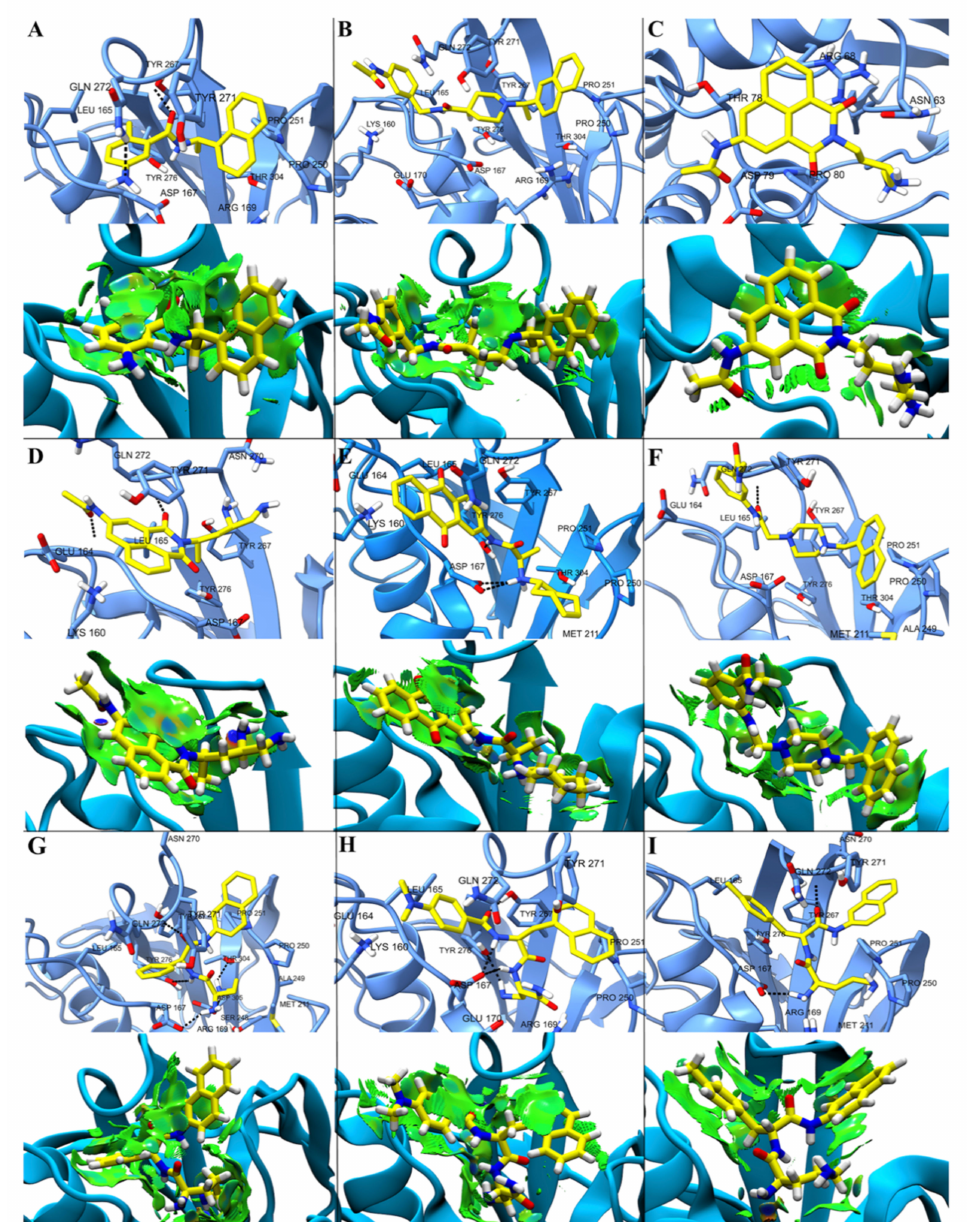
Figure 6. Non-covalent interactions in the representative conformation of the PLpro/ligand com- plex obtained by cluster analysis. The amino acids surrounding with controls GRL0617 and 12C ( A and B , respectively) and selected ligands D24, D28, D04, D59, D60, D99, and D06 ( C , D , E , F , G , H , and I, respectively) in the PLpro binding pocket are highlighted (upper figures), and in the two-dimensional PLpro/ligand interaction map (lower figures) the NCIPLOT isosurface gradient (0.5 au) is highlighted. Dashed lines indicate possible interactions between amino acids and adjacent